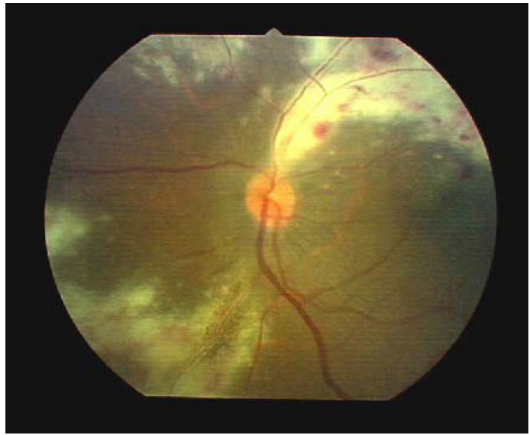
Figure 2 CMV retinitis (Photo courtesy of Dr Linda Visser) Toxoplasma retinochoroiditis